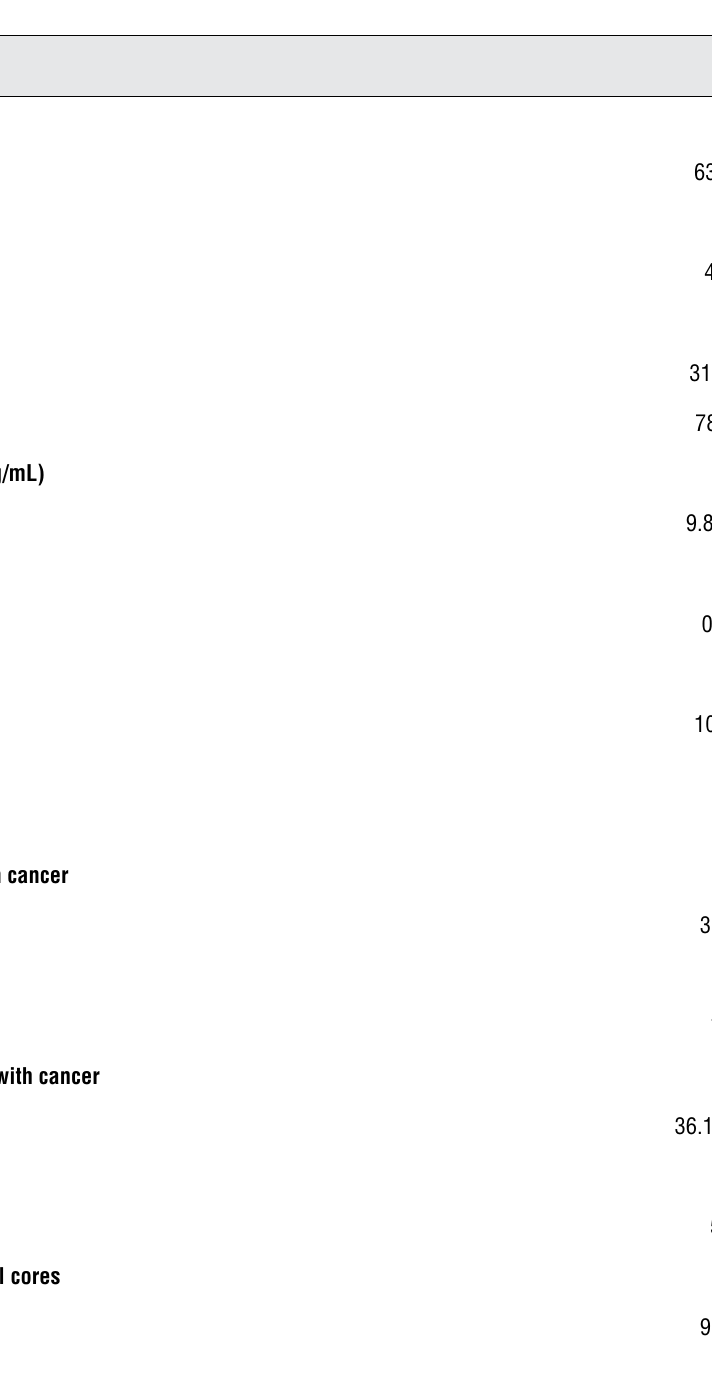
Table 1 - Clinicopathologic characteristics of 400 study patients submitted to radical prostatectomy for prostate cancer. SD, standard